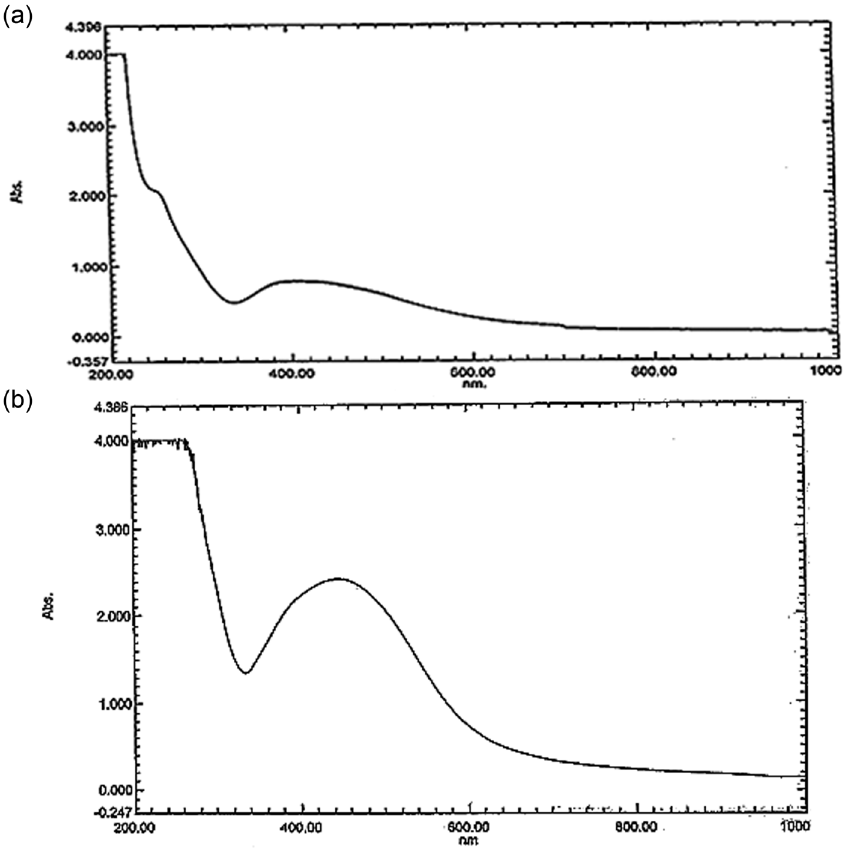
Figure 2: ( a ) UV - VIS of Ag - NPs ( fi rst experiment ) and ( b ) UV - VIS of Ag - NPs ( second experiment )